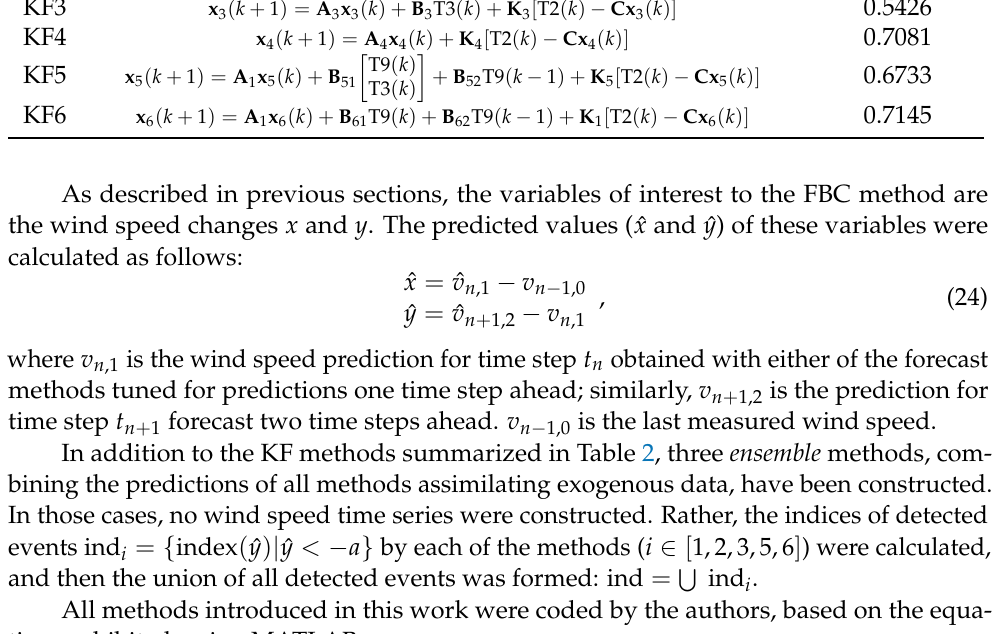
(cid:0) (cid:1) N p = 2 . T2 is the target tower, and T3 and